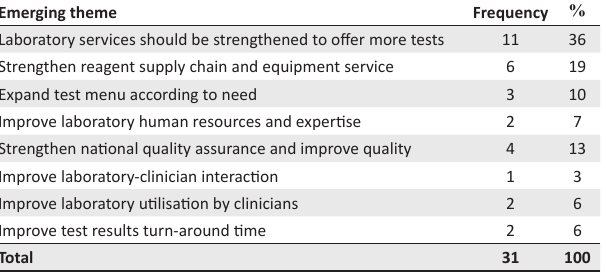
TABLE 8: Key informants ’ emerging themes, Malawi, October-November 2012. † Emerging